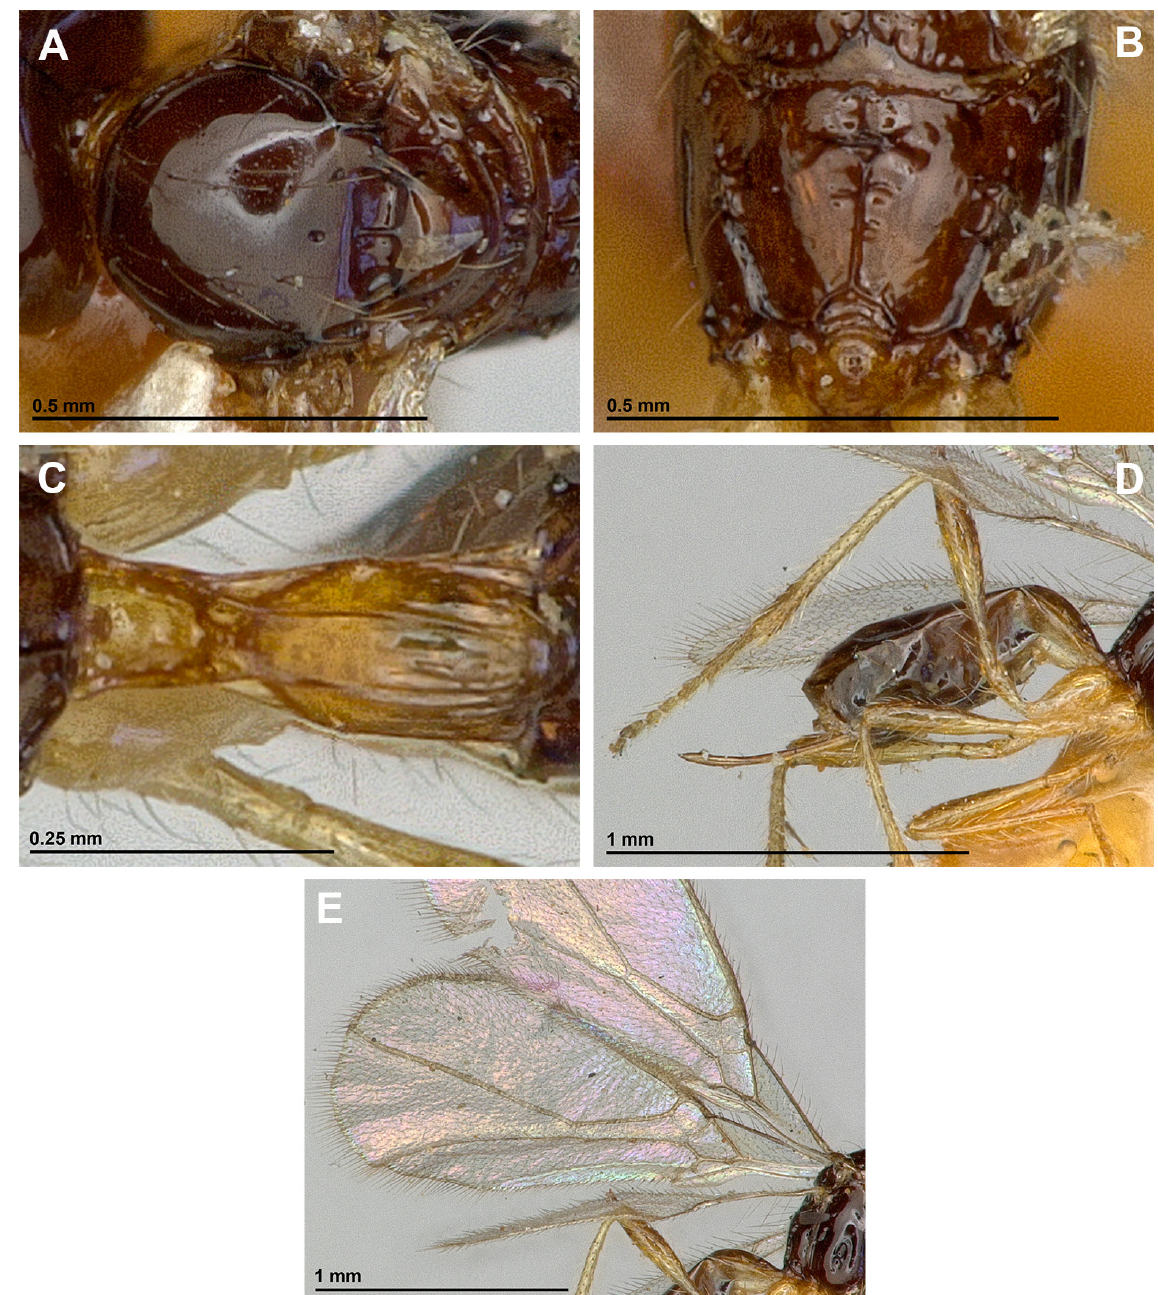
Fig. 9. Dinotrema teutoniaense Peris-Felipo sp. nov. (♀). A . Mesonotum, dorsal view. B . Propodeum, dorsal view. C . First metasomal tergite. D . Metasoma, hind leg and ovipositor, lateral view. E . Fore and hind